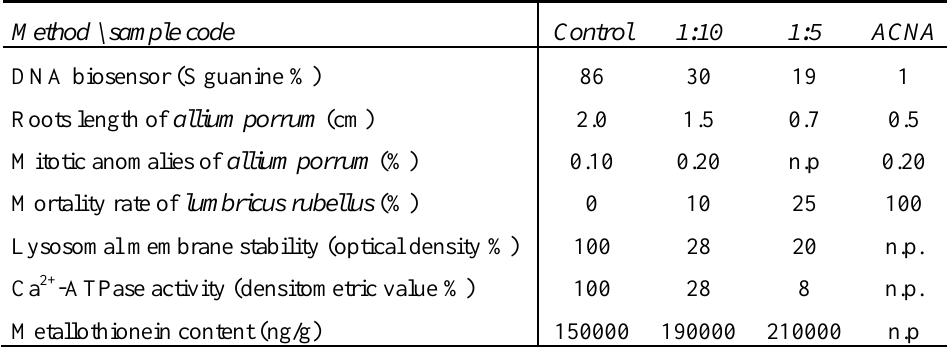
Method \ sample code Control 1:10